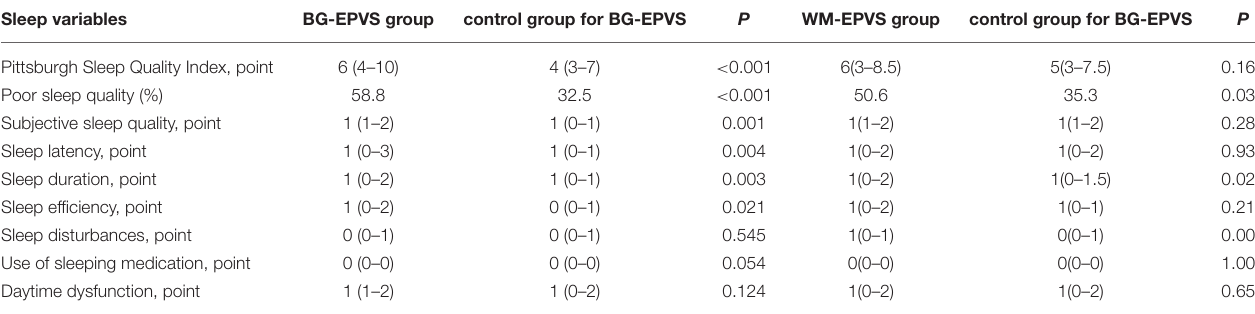
TABLE 2 | Sleep variables by Pittsburg Sleep Quality Index of the enlarged perivascular space (EPVS) group and the control group.